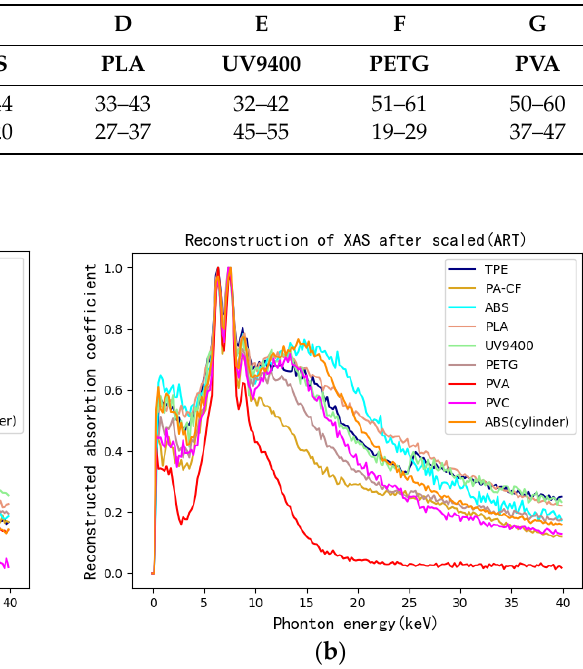
Table 4. Coordinate descriptions of ROI in Figure 7 for each kind of polymers.